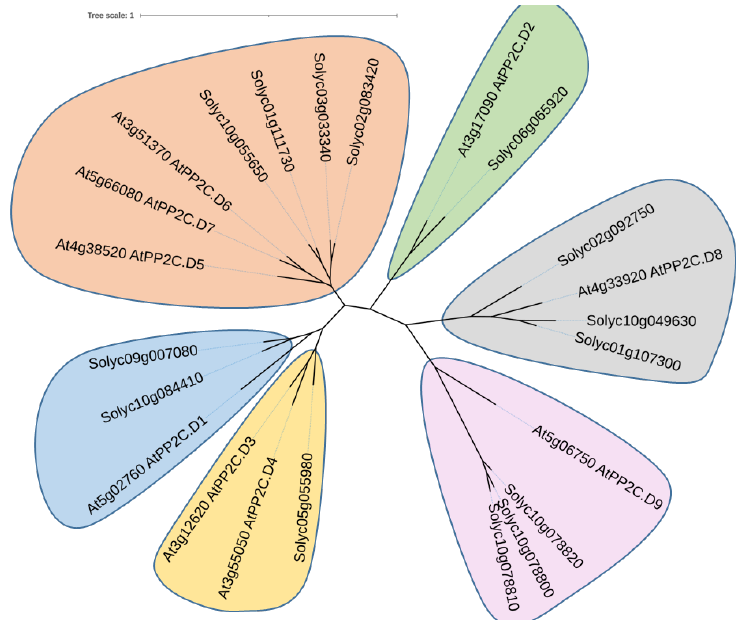
Figure 4. Phylogenetic relationship of PP2C.D proteins from tomato and Arabidopsis. The amino acid sequences of tomato and Arabidopsis PP2C.D proteins were aligned, and a phylogenetic tree was drawn using the maximum-likelihood method with 1000 bootstrap repeats, and the phylogenetic tree was constructed using MEGA X program.